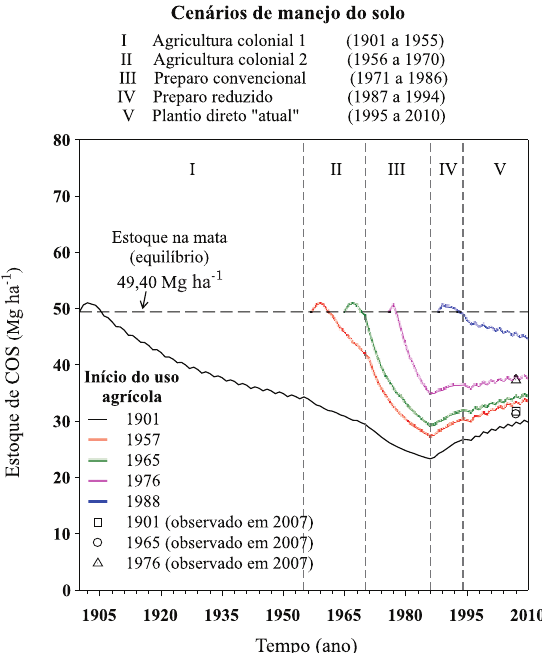
Figura 5. evolução dos estoques de carbono orgânico do solo (cos) em diferentes épocas de início do uso agrícola, estimada pelo modelo century na camada de 0 a 20 cm em latossolo de topo, considerando diferentes cenários de manejo do solo adotados no distrito santana, ijuí-rs, e valores observados por bortolon (2008) para o ano de 2007, obtidos em lavouras iniciadas em 1901, 1965 e